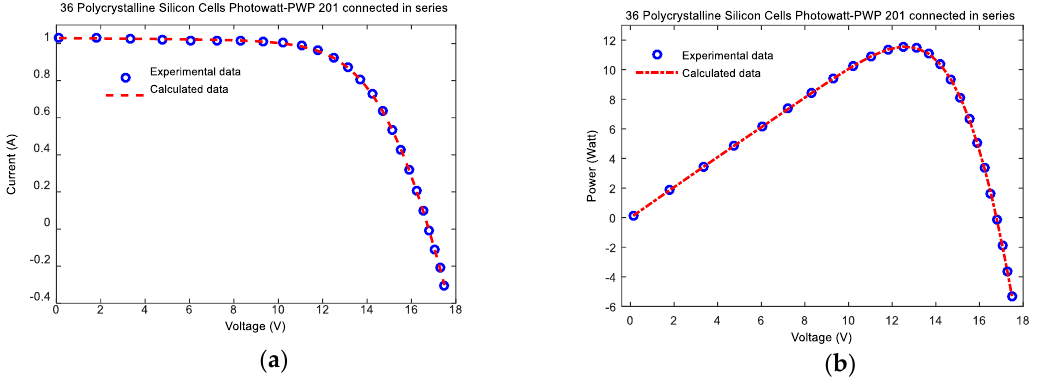
Figure 13. Comparison of ( a ) I-V and ( b ) P-V curve between experimentally recorded data for photovoltaic module Photowatt-PWP 201 and the estimated results by FA.